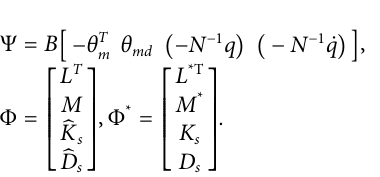
Frontiers in Robotics and AI |